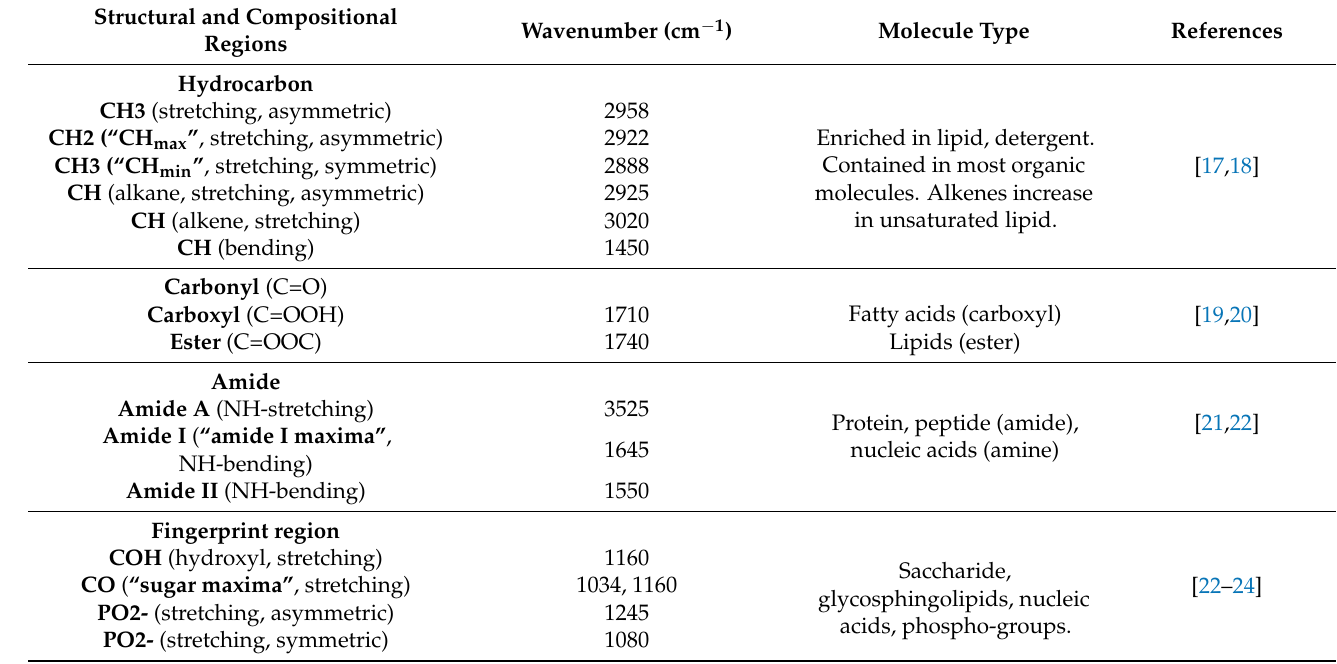
Table 2. Distinguishing spectral features in biological molecules. A collection of the most distinctive vibrational frequencies (in wavenumber) detected in tested biological molecules, with biological interpretations and chemical structure